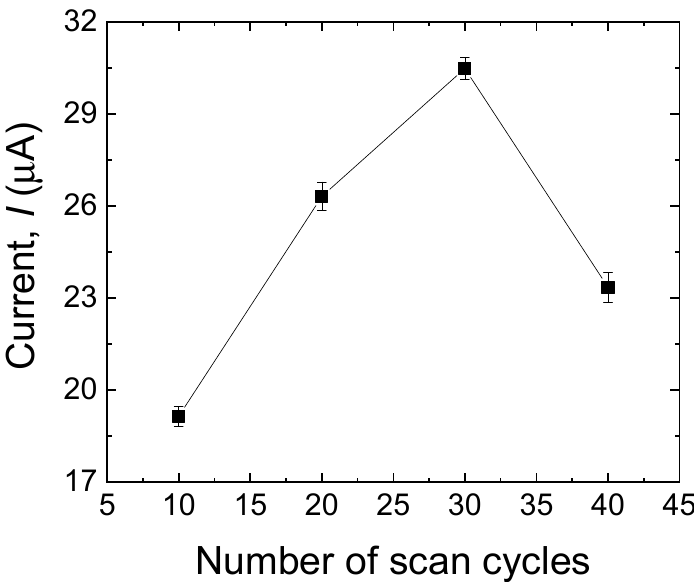
Figure 4. Effect of a different number of scan cycles in the electropolymerization process on the anodic peak currents of MDA (500 µM). Error bars are calculated from three independent replicates.